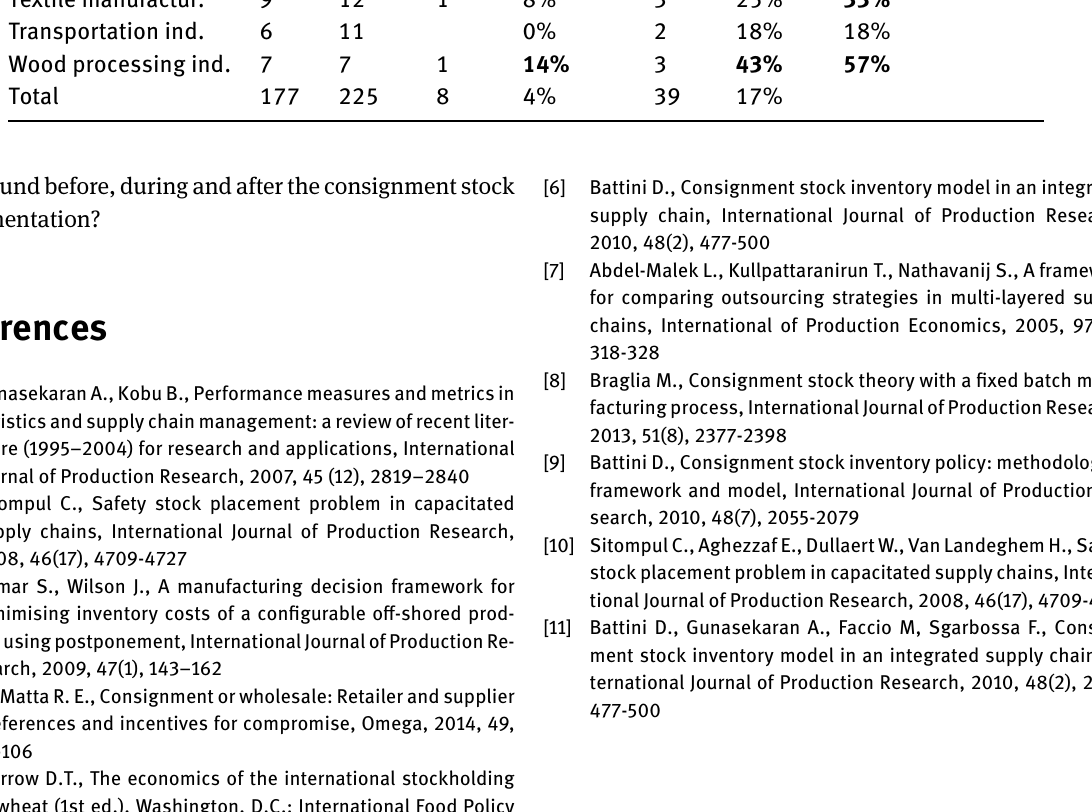
Wood processing ind.